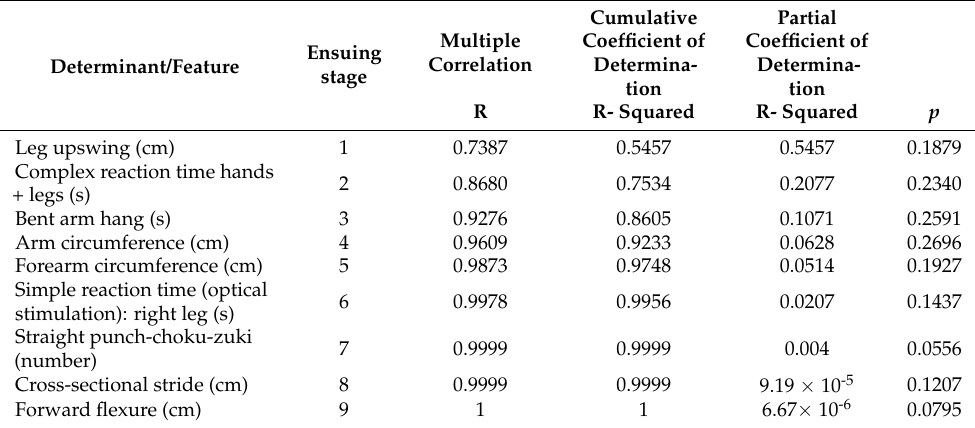
Table 7. Summary regression details from the 2nd study stage for male participants; dependent variable = ranking points.